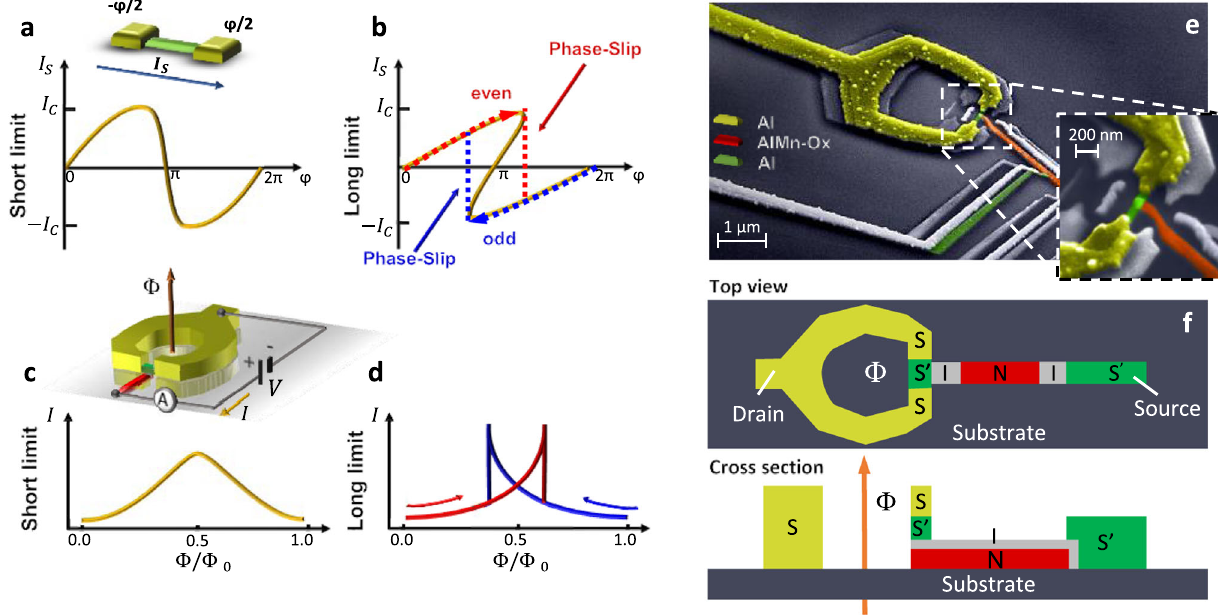
Fig. 1 Phase-slip memory working principle and structure. a , b Sketch of the current-phase relation (CPR, I s ( φ )) for a S-S ′ -S weak link (schemed on top) in the short a and long b junction regime. The CPR (yellow curve) evolves from a deformed sinusoid to a multi-valued function as the junction length increases. In the latter, the transition between the two topologically protected states, corresponding to even and odd topological index 4 , occurs via phase- slips in the wire 2,31 and corresponds to the vertical jump indicated by the colored arrows between the two current branches (red and blue). c , d Dependence of the tunnel current ( I ) on the normalized applied magnetic fl ux ( Φ / Φ 0 , with Φ 0 = h /2 e ≃ 2*10 − 15 Wb the fl ux quantum), at fi xed bias voltage ( V ) for a SQUIPT in the short c and long d junction regime. In the latter case, the current evolution shows a hysteretic pro fi le (red and blue curves), which stems from the multi-valued CPR. Top: scheme of a voltage-biased DC SQUIPT in a two-wire con fi guration. Φ is the magnetic fl ux piercing the ring. e Pseudo-color scanning electron micrograph of a typical PSM. An Al nanowire (green) is inserted in a micron-size Al ring (yellow), whereas an Al 0.98 Mn 0.02 probing electrode (red) is tunnel-coupled to the middle of the nanowire and to a second Al electrode (green) via an insulating oxide layer (gray) to allow the memory operation. Inset: blow-up of the weak-link region. The passive replicas due to the three-angle shadow-mask metal deposition are visible. f Schematic top-view and cross-section of the